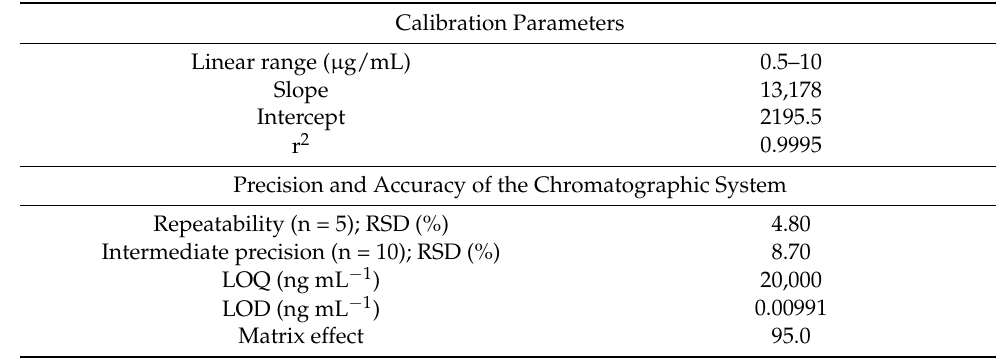
Table 2. Validation parameters for the quantitative analysis of